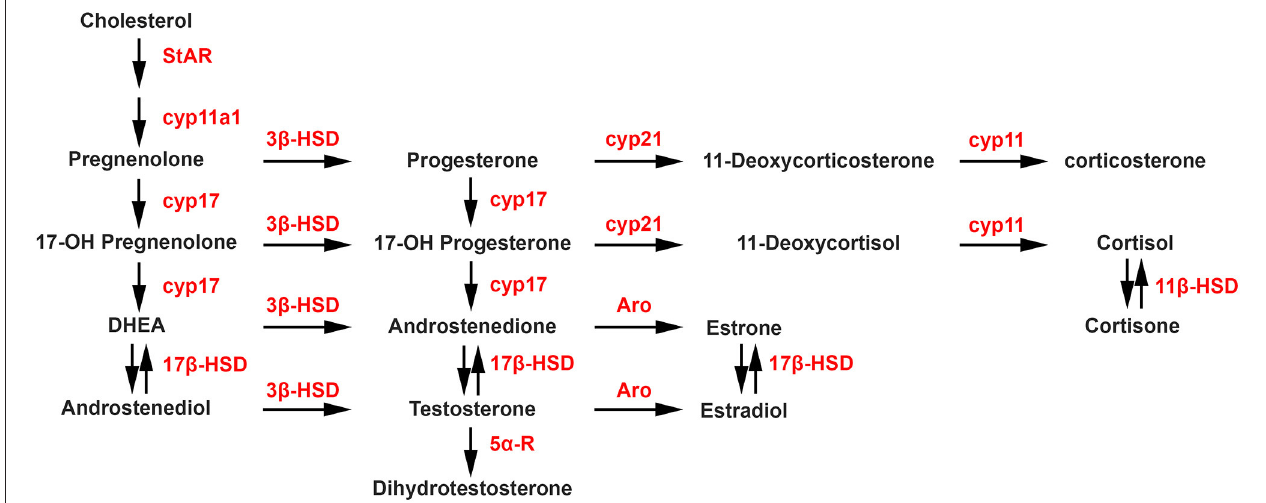
FIGURE 1 | Biosynthetic pathways of neurosteroid synthesis. Cyp11a1, cytochrome P450 family 11 subfamily A member 1 (P450scc), cytochrome P450 side-chain cleavage; Cyp17, cytochrome P450 17 α -hydroxylase/C17, 20-lyase; Aro, aromatase; 3 β -HSD, 3 β -hydroxysteroid dehydrogenase D5–D4 isomerase; 5 α -R, 5 α -reductase; 17 β -HSD, 17 β -hydroxysteroid dehydrogenase; Cyp21, cytochrome P450 21 hydroxylase; Cyp11, cytochrome P450 11 β -hydroxylase B1 and/or B2. StAR, steroidogenic acute regulatory